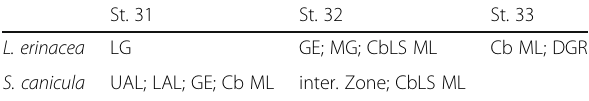
Table 1 A timeline of comparative cerebellar and cerebellar-like development in L. erinacea and S.